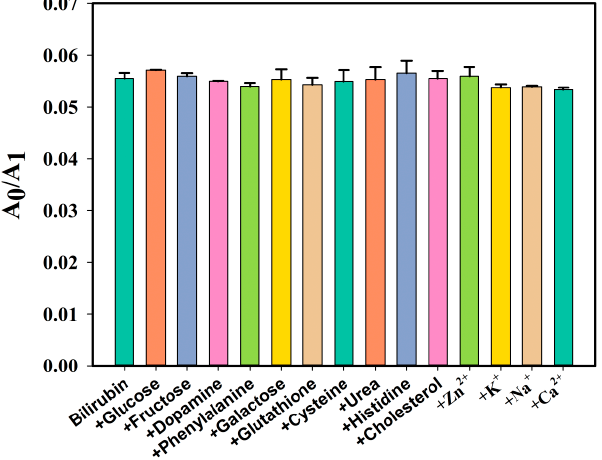
Figure 6. Interference experiments for the common substances co-existed with bilirubin. The comparisons of the analytical parameters, such as linear range and limits of detection for bilirubin based on various analytical processes, are shown in Table 1. This proposed method has a relatively rapid response to bilirubin. Both its detection limit and linear range are comparable with the other reported methods. Table 1. Comparison of analytical parameters for the detection of bilirubin by different materials and methods.